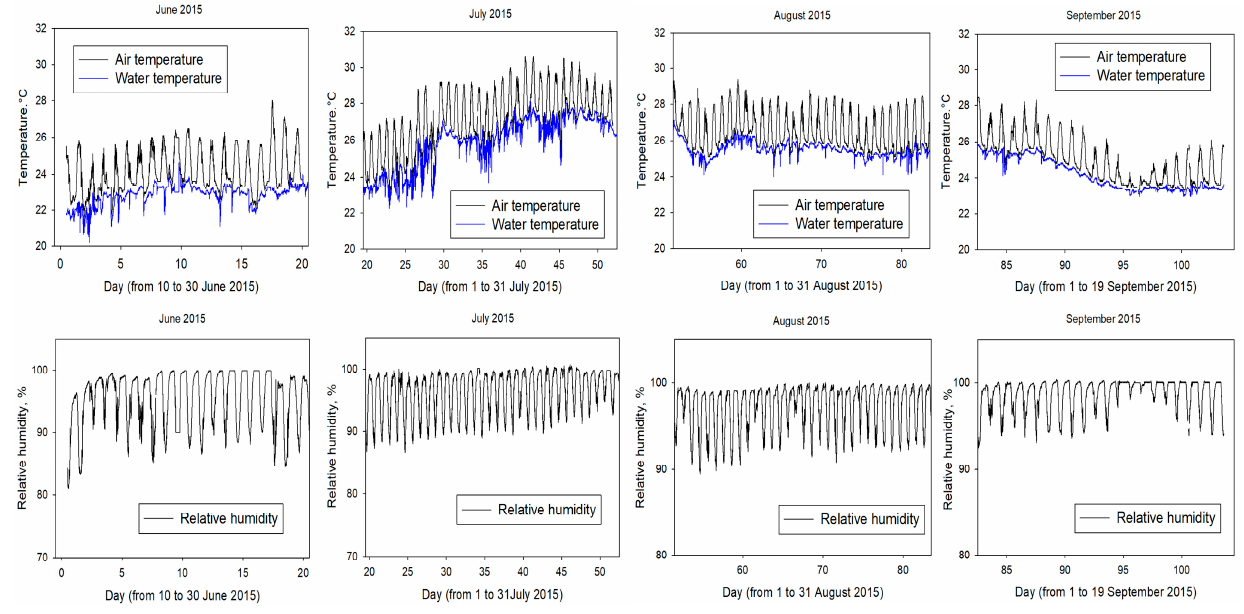
Figure 2. Measured variations over time of air and water temperature ( top ) and air relative humidity ( bottom ) during the summertime of the year 2015 in an underwater greenhouse.